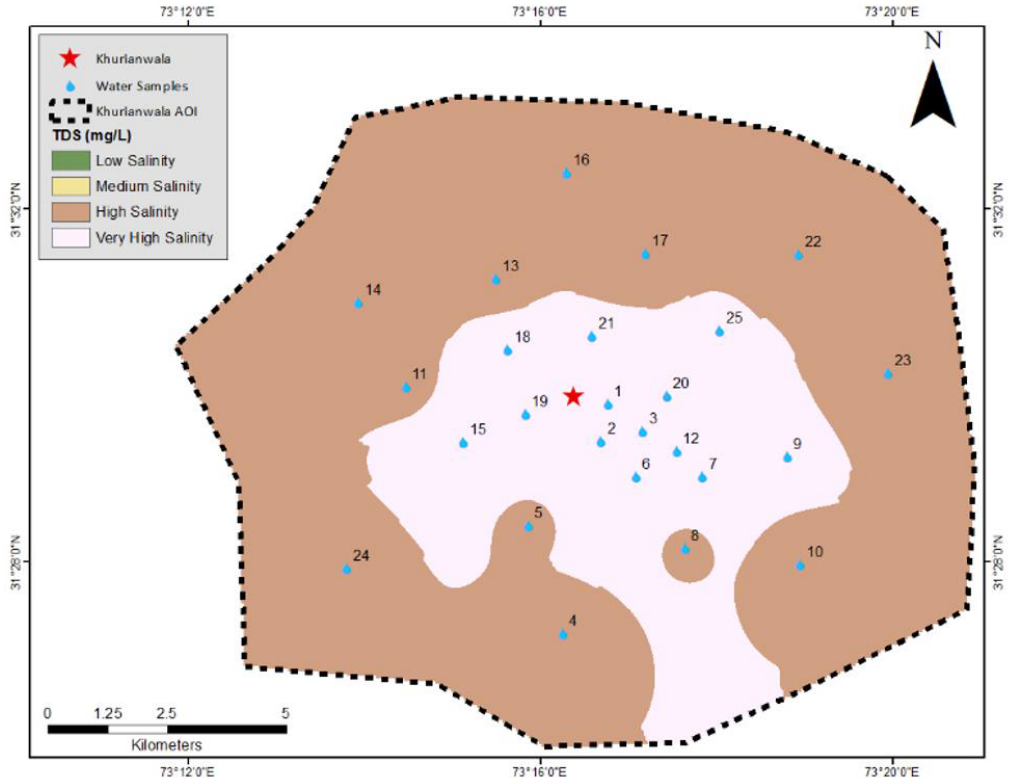
Figure 3. Mapping according to the distribution of total dissolved solids (TDS) values based on drinking water quality